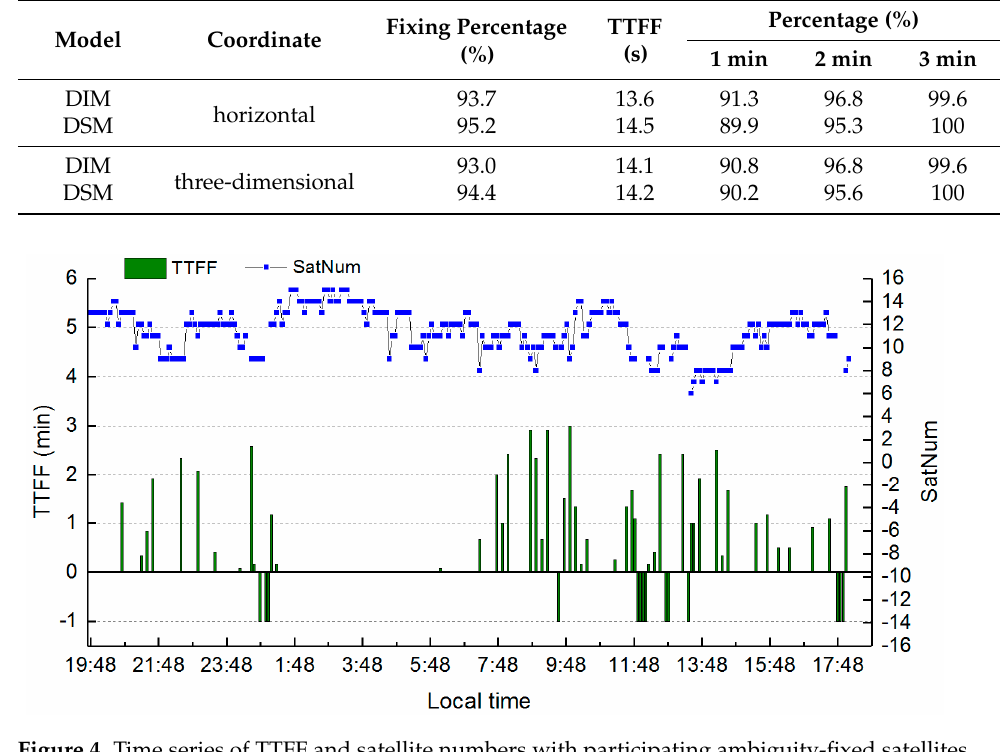
( b ) Figure 5. Positioning bias in ( a ) horizontal direction and ( b ) vertical direction at TTFF.